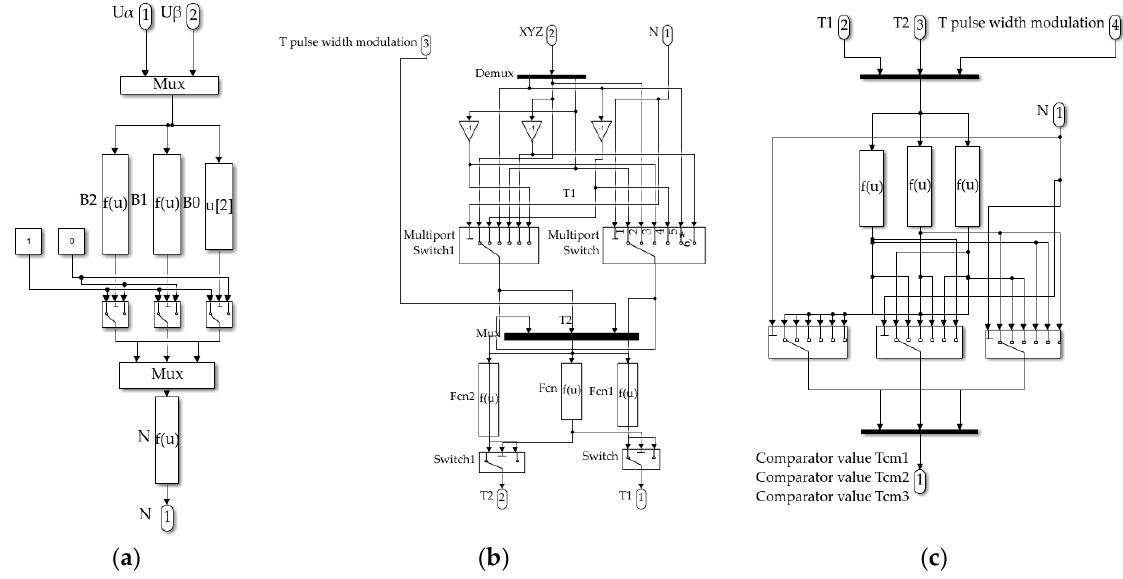
Figure 14. The SVPWM system ( a ) Sector determination module ( b ) Voltage vector action time module ( c ) Voltage vector switching point module. The coordinate transformation module is shown in Figure 15.